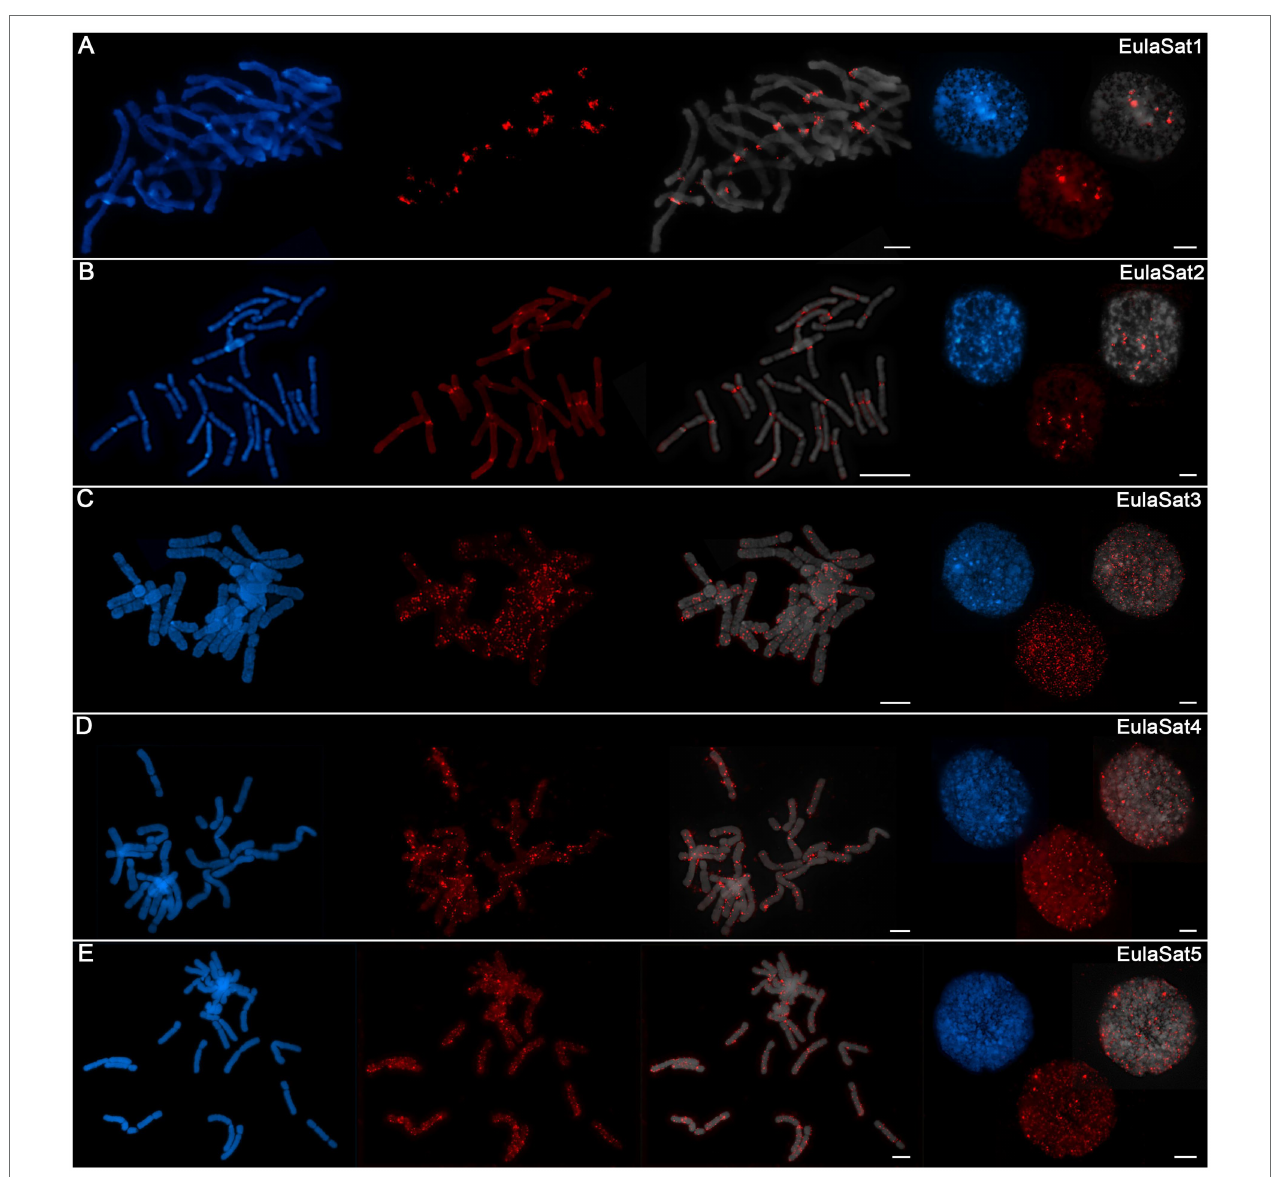
FIGURE 4 | Chromosomal localization of the EulaSat families along Larix decidua chromosomes. Chromosomes have been counterstained with DAPI, indicated in blue and gray. Fluorescent in situ hybridizations of EulaSat1 (A) , EulaSat2 (B) , EulaSat3 (C) , EulaSat4 (D) , and EulaSat5 (E) to L. decidua meta- and interphases are shown in